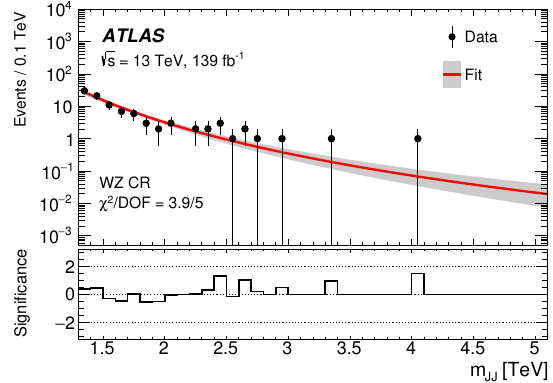
Figure 7 . Comparison between (cid:12)tted background shape and the m (cid:12)t control region in data. The (cid:12)tted background distribution is normalised to the data shown in the displayed mass range. The shaded bands represent the uncertainty in the background expectation calculated from the maximum-likelihood function. The lower panel shows the signi(cid:12)cance, de(cid:12)ned as the z -value as described in ref.